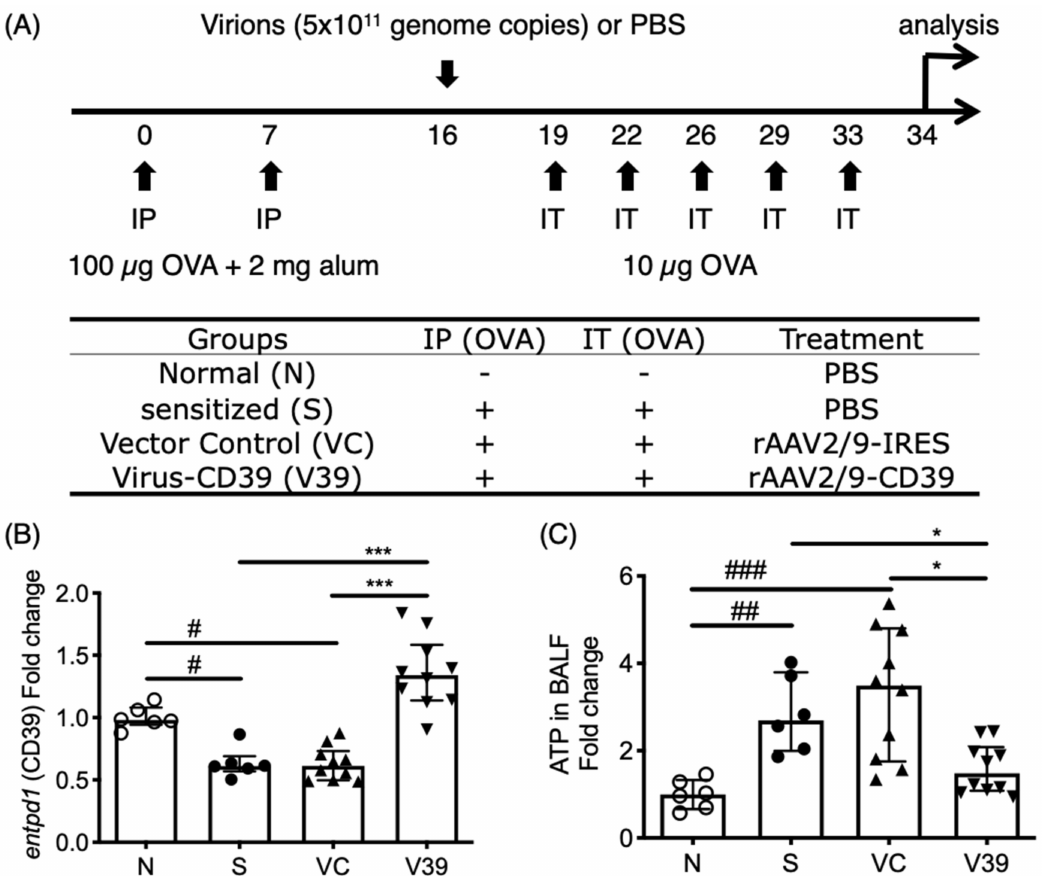
Figure 1. ATP levels in bronchoalveolar lavage fluid (BALF) of rAAV-CD39 treated mice was downregulated with rescued expression of CD39. ( A ) Brief protocol for OVA sensitization and rAAV-CD39 treatment. Mice were sensitized by intraperitoneal injection (IP) of OVA/alum on days 0 and 7 and were challenged by OVA 5 times within 2 weeks. rAAV-CD39 was intratracheally (IT) administrated on day 16. ( B ) The relative expression level of CD39 (gene symbol: entpd1 ) to β -actin ( actb ) in the lungs was increased in the rAAV-CD39 treated group, compared to the controls. ( C ) The relative ATP level to the normal controls in BALF was decreased in rAAV-CD39 treated group. ATP levels were determined with ATPlite analysis. Data are presented as median with interquartile range (* p < 0.05, *** p < 0.001 in the comparison of V39 with S or VC; # p < 0.05, ## p < 0.01, ### p < 0.001 in the comparison of N with S or